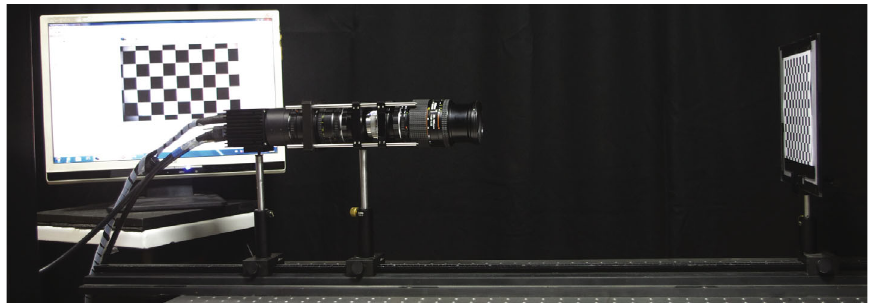
Figure 15: The physical map of the measurement system